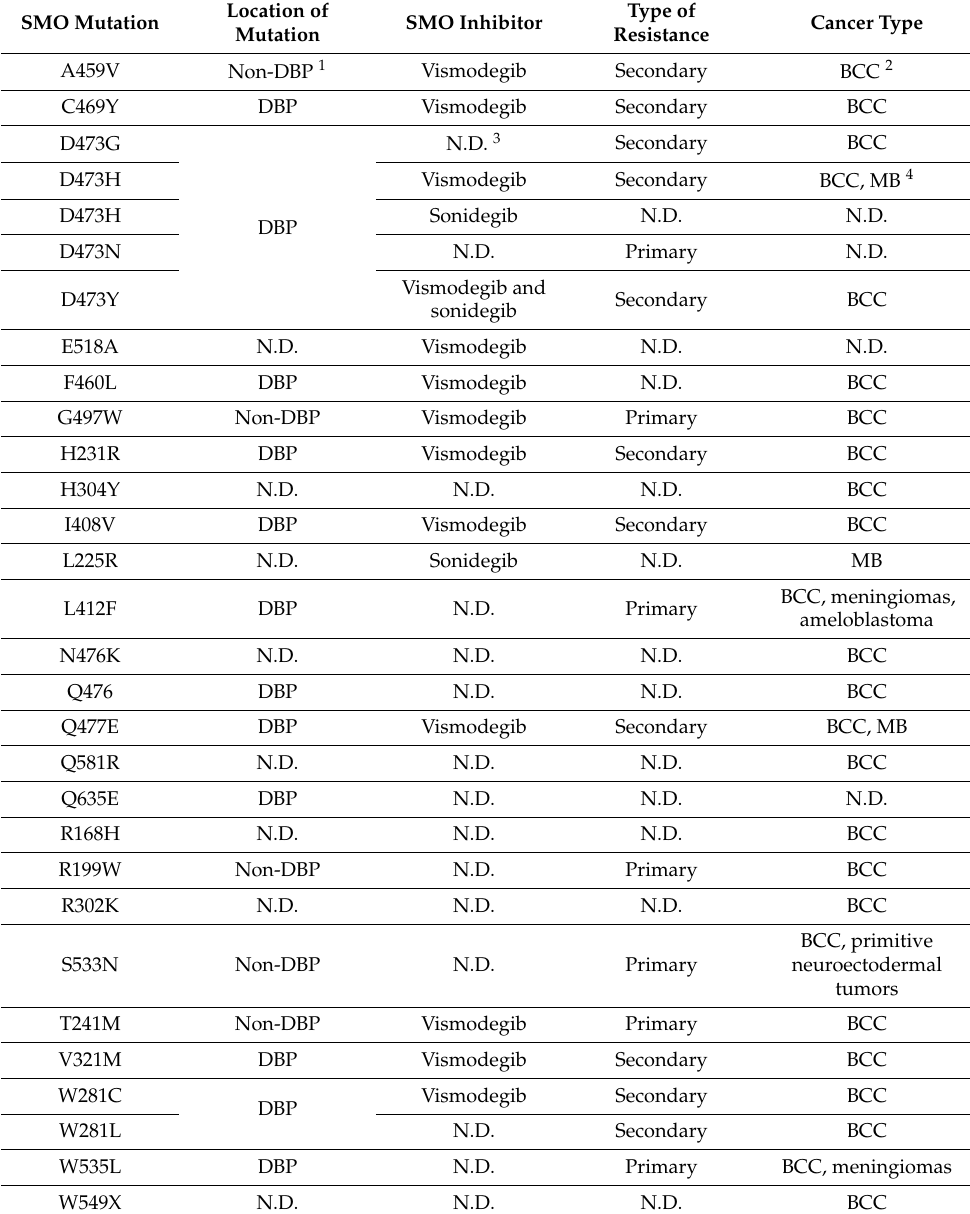
Table 2. SMO mutations associated with drug resistance found in the clinical context. SMO